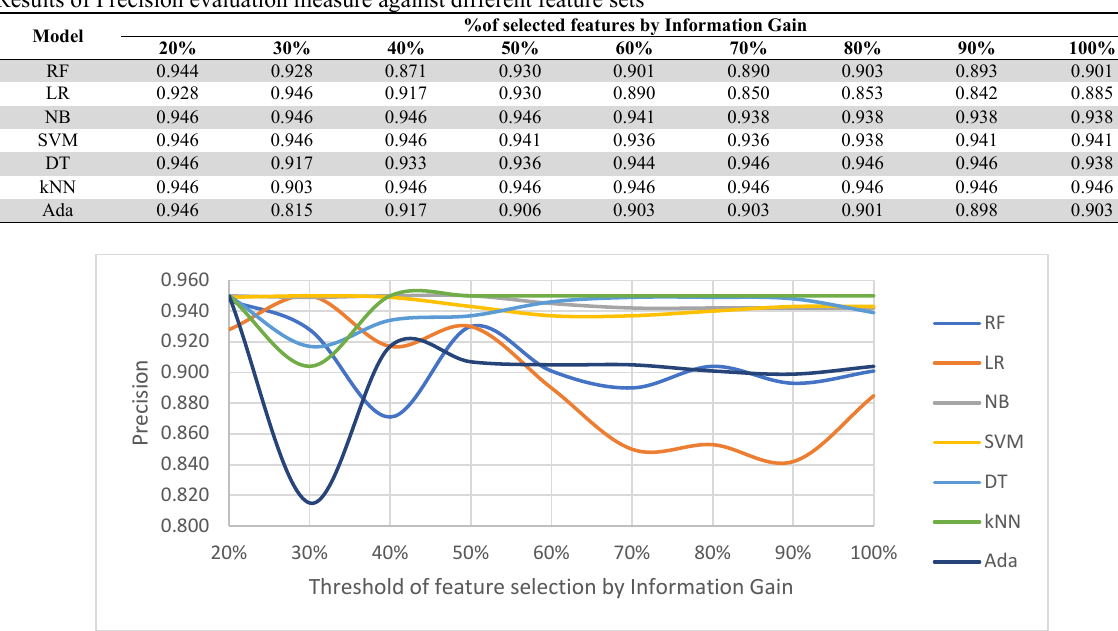
Fig. 8. Precision results for the comparison between different machine learning models using IG